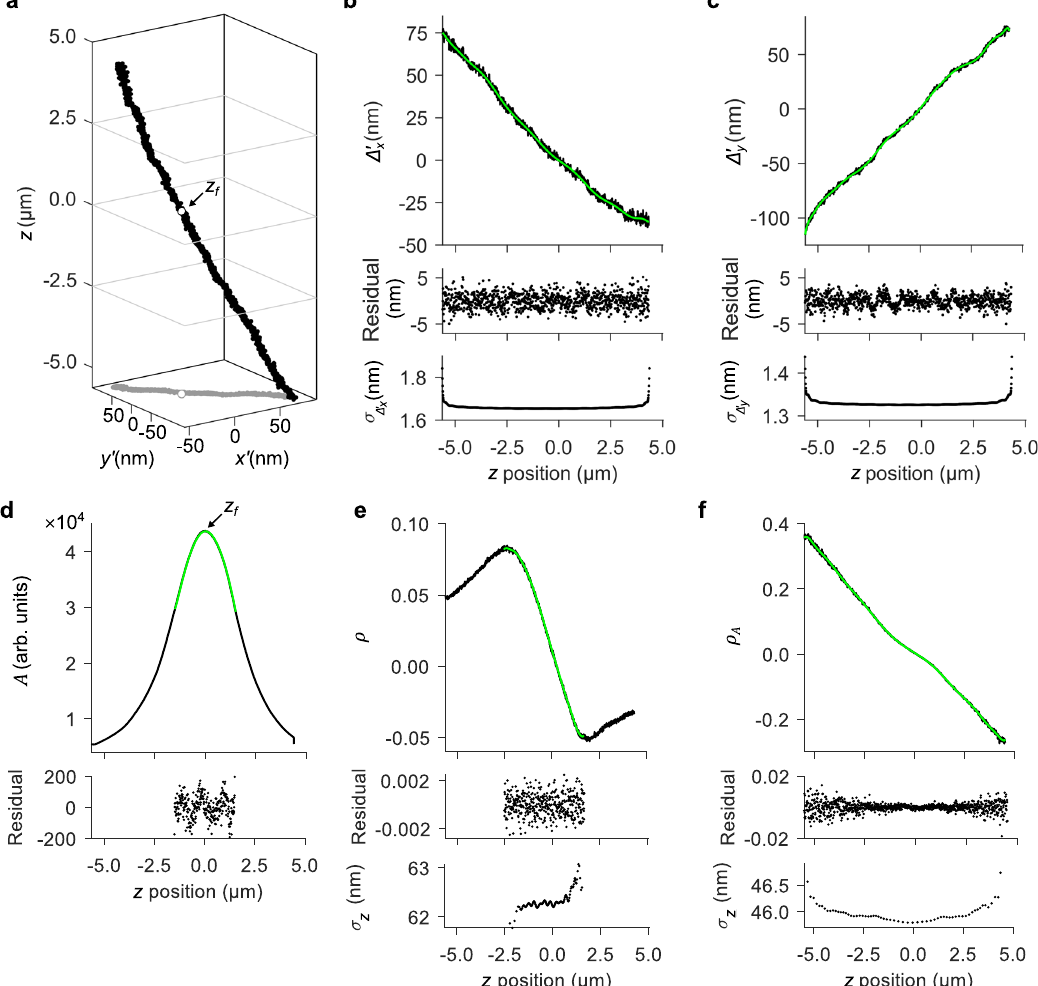
Fig. 2 Effects of intrinsic aberrations on apparent lateral position and particle image shape. These data are from a representative calibration particle at a representative location in the imaging fi eld. a Scatter plot showing apparent lateral position as a function of actual axial position. White data markers indicate the actual lateral position, which we de fi ne at the axial position of best focus z f . Uncertainties are smaller than the data markers. b – f Plots showing the dependence on axial position of the parameters ( b ) Δ 0 x ð z Þ ¼ x 0 ð z Þ (cid:3) x 0 ð z f Þ , ( c ) Δ 0 y ð z Þ ¼ y 0 ð z Þ (cid:3) y 0 ð z f Þ , ( d ) A , ( e ) ρ , and ( f ) ρ A ¼ ρ A , where A n ¼ A = A ρ is ¼ ρ 0 n the amplitude after normalization to its value in the image for which ρ = ρ 0 , with ρ 0 set to the minimum value of | ρ |. Fits of bivariate Gaussian models to emitter images determine the (black data markers) parameter values, and (green lines) polynomials model the z dependence for ( b – c ) lateral correction, ( d ) determination of the axial position of best focus z f , and ( e - f ) axial localization. Residual values indicate an uncertainty for each parameter. Values in the bottom panels are uncertainties of ( b - c ) apparent lateral position σ Δ 0 and σ Δ 0 from the polynomial models, and ( e – f ) z position σ z from inversion of the x y polynomial